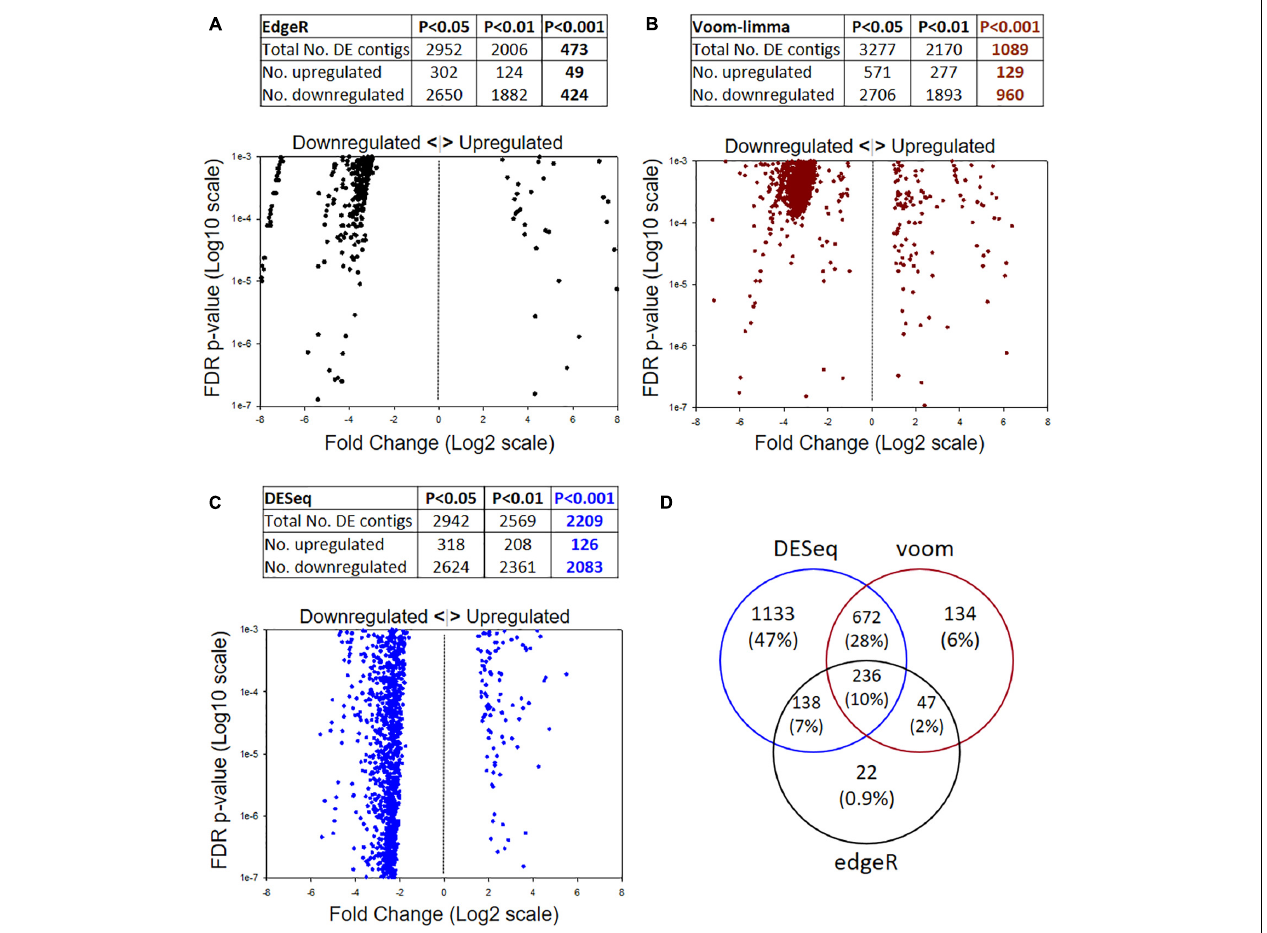
FIGURE 2 | Illumina metatranscriptome analysis by three different models: (A) edgeR, (B) voom-limma and (C) DESeq. The top of each panel shows summary statistics for differentially expressed contigs and different false discovery rate (FDR) p -values. The bottom of each panel shows scatter plots of Log2 Fold Change ( x ) by p -value ( y ) for the FDR P < 0.001 datasets. (D) Venn diagram showing the numbers of passing contigs at the P < 0.001 level shared among different analysis models. The edgeR model was the most stringent at the P < 0.001